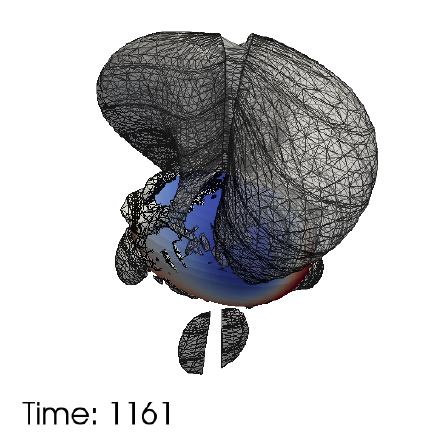
Figure 4. A contour of (cid:60) ( Ψ 4 ) for the SK simulation immediately after the merger, with Ψ 4 extracted on the quasi-Kinnersley tetrad. Also shown is the common apparent horizon colored by the horizon vorticity B NN . The (cid:60) ( Ψ 4 ) contour connects to certain blue horizon vorticity patches. These are the negative B NN counterparts to the C (cid:48) patch of Figure 5d below, which we will show in Section 4 to be a direct manifestation of the remnant spins. Note that there is some visualization complication near the polar directions, where we don’t have any collocation points, so the contour shown there is an ill-constructed interpolation.